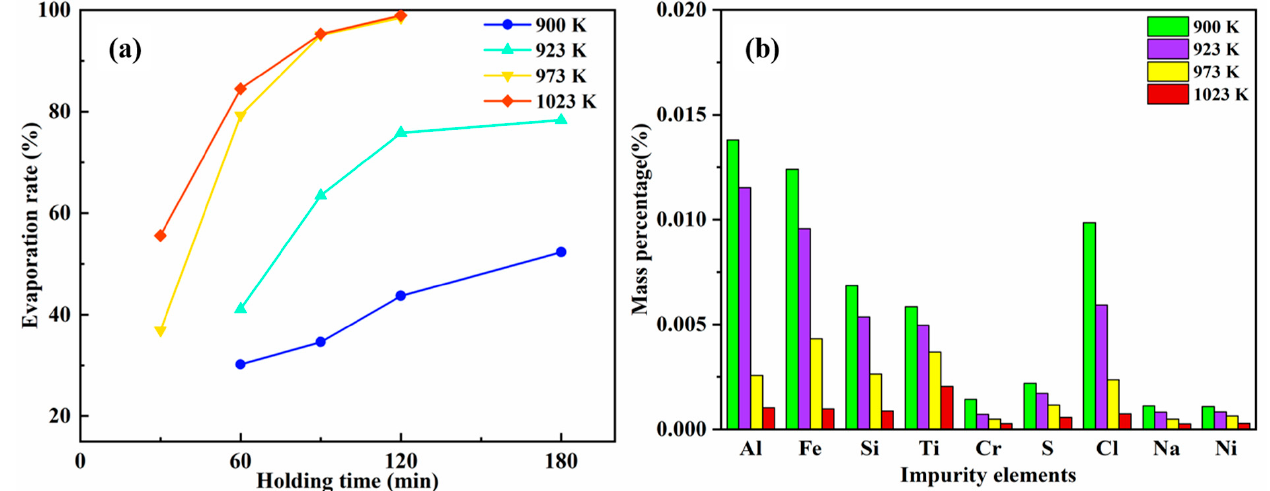
Figure 6. Effect of the distillation temperature and time on ( a ) the evaporation yield of Mg and ( b ) the removal of the impurity elements.